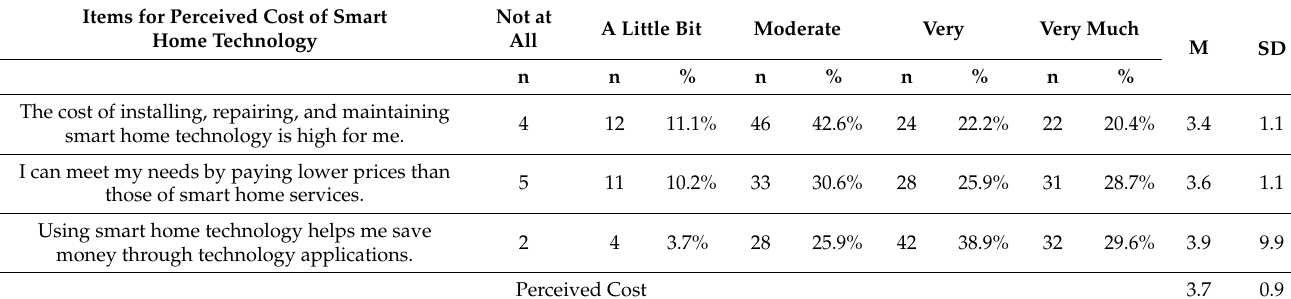
Table A4. Perceived cost of smart home technology.